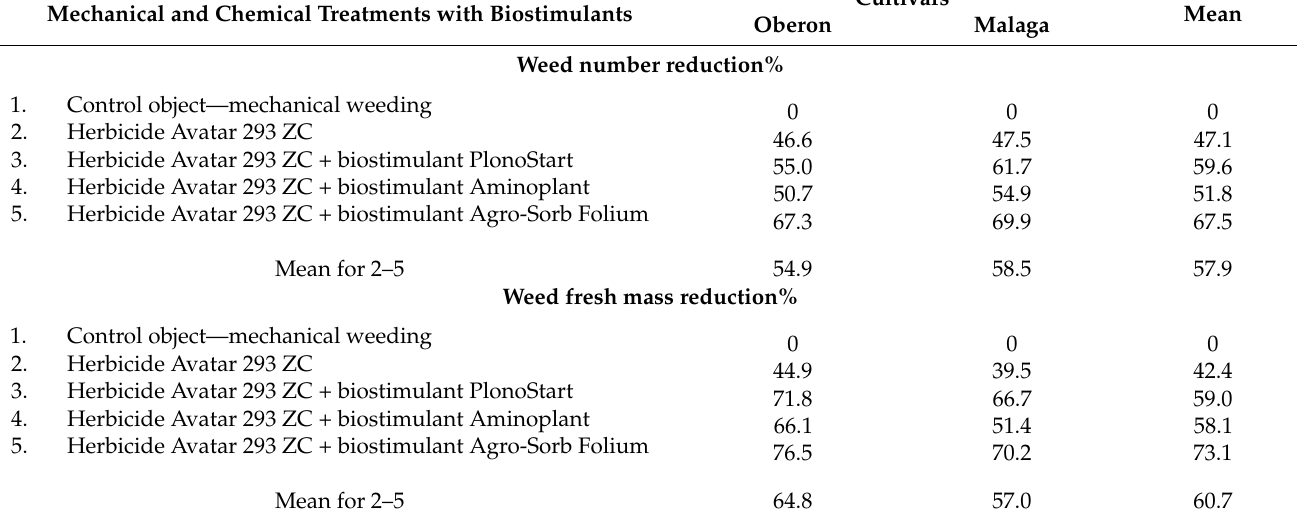
Table 3. Weed number reduction (%) in relation to the control object before the row closing of the